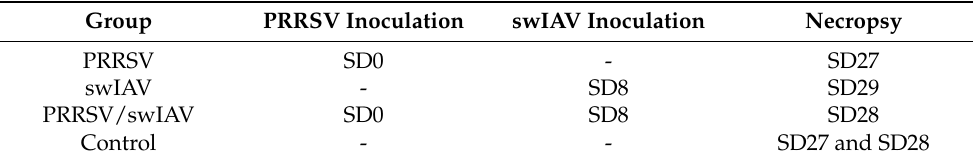
Table 1. Experimental